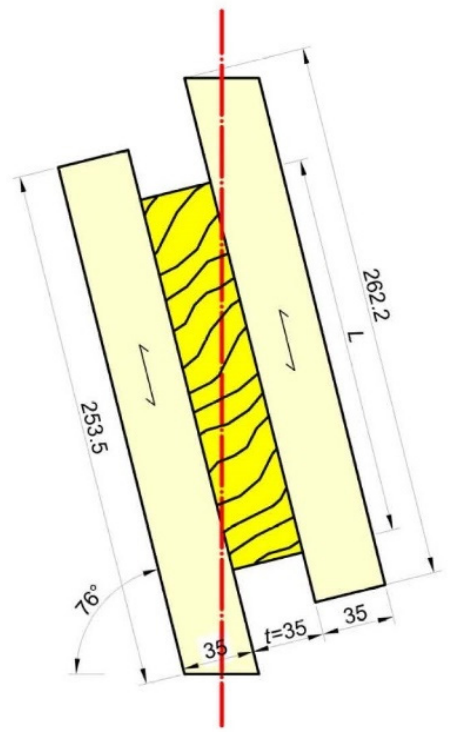
Figure 1. Schematic of the specimen. The wood of the specimens had an average density of 459 kg/m 3 and an average moisture content of 11.4%. The test blocks made from dimension lumber with